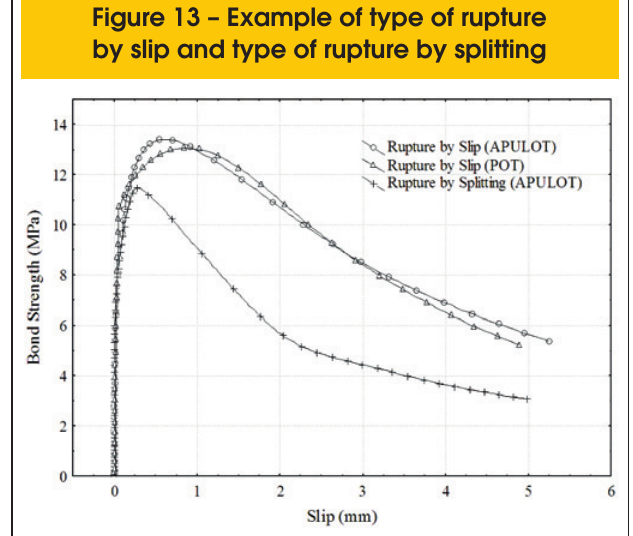
Figure 13 – Example of type of rupture by slip and type of rupture by